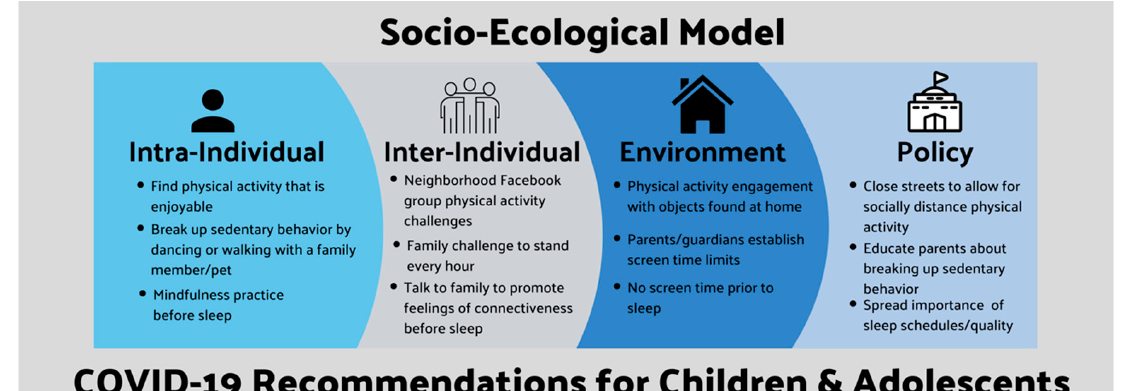
Figure 2. Socio-ecological model behavior recommendations during the COVID-19 pandemic.